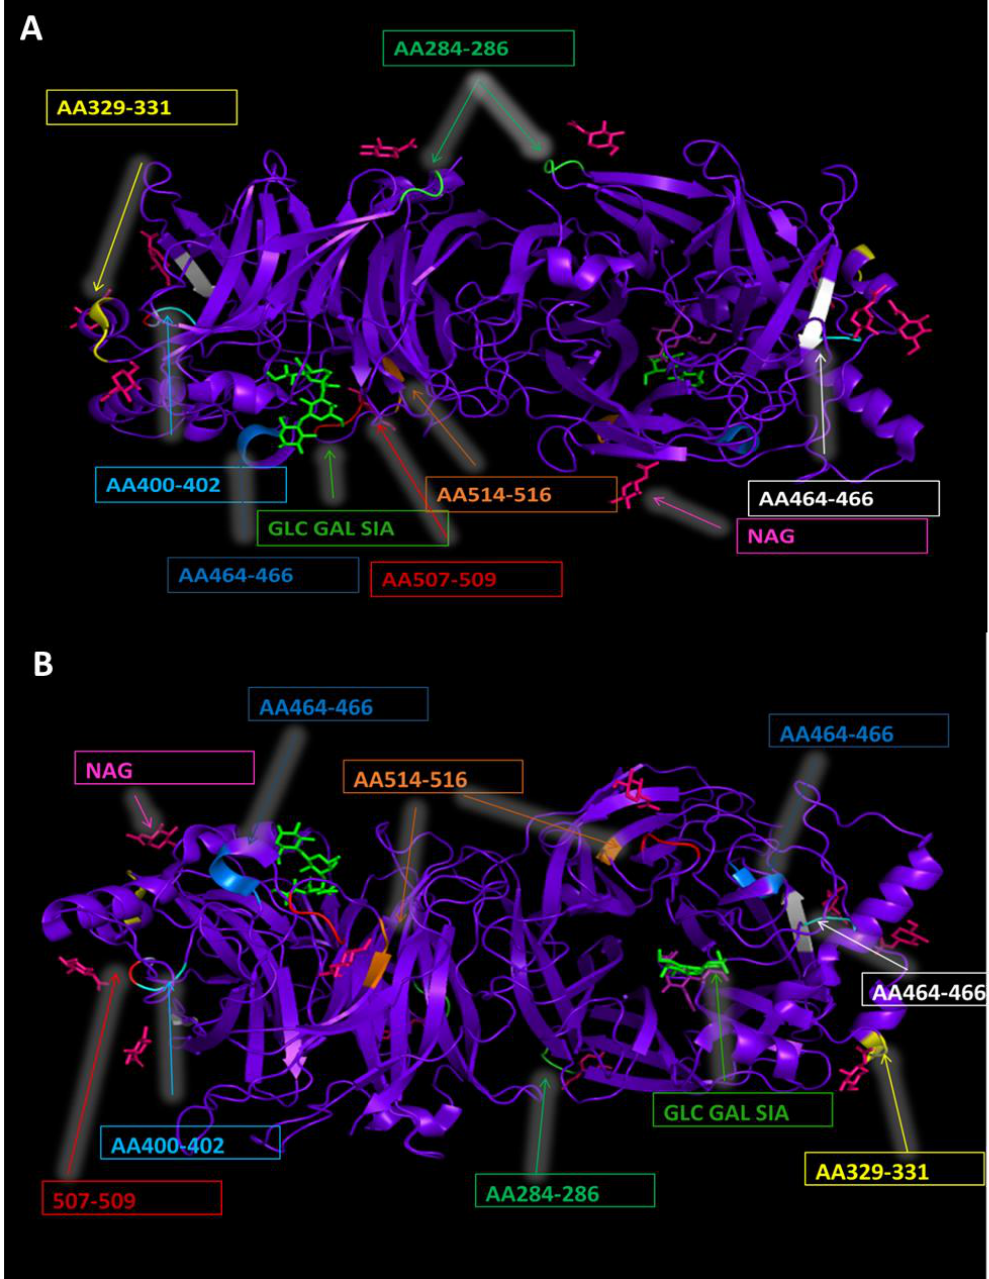
Figure 1. Protein structures generated from Protein Data Base file 5B2D [26]. ( A ) Protein binding sites and N-glycosylation sites of mumps HN protein (front view). Illustrated are the HN protein (purple), N-acetyl-D-glucosamine binding sites (pink), and sialic acid receptor binding sites (green). Different N-glycosylation sites are labelled with arrows and boxes indicate the amino acid range. ( B ) Protein binding sites and N-glycosylation sites of mumps HN protein (back view). Illustrated are the HN protein (purple), N-acetyl-D-glucosamine binding sites (pink), and sialic acid receptor binding sites (green). Different N-glycosylation sites are labelled with arrows and boxes indicate the amino acid range.